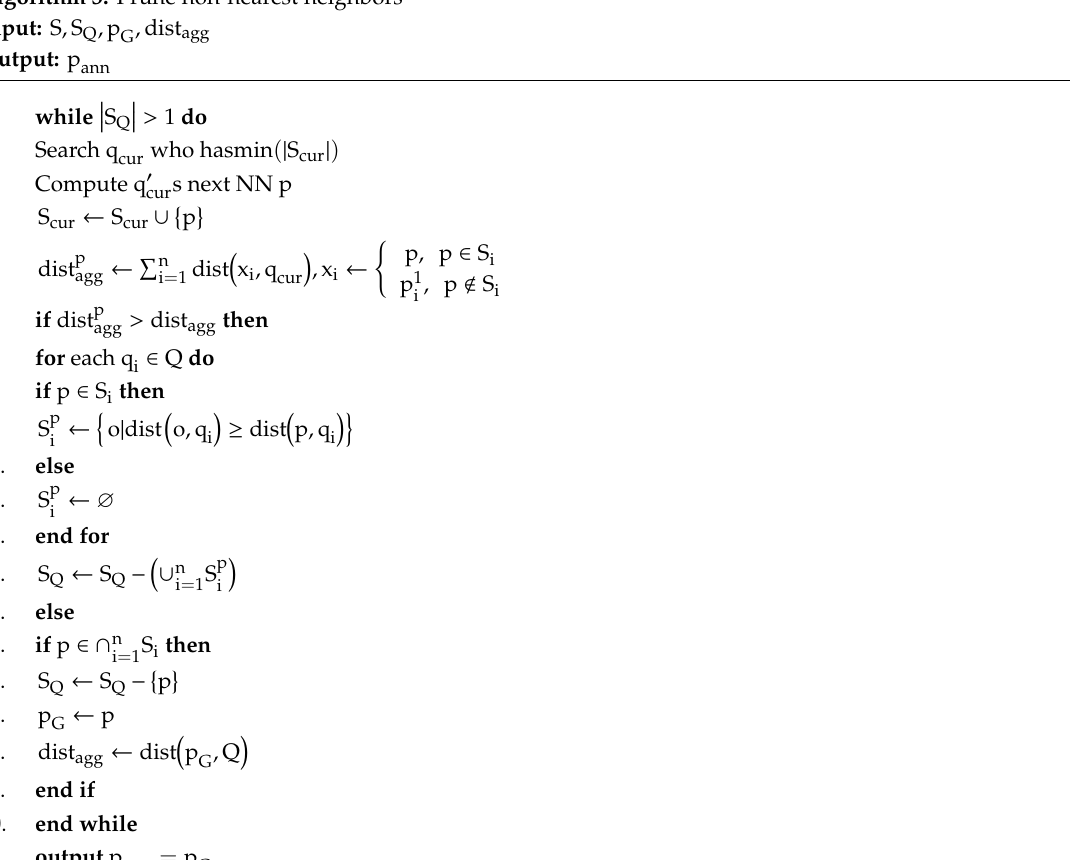
Algorithm 3: Prune non-nearest